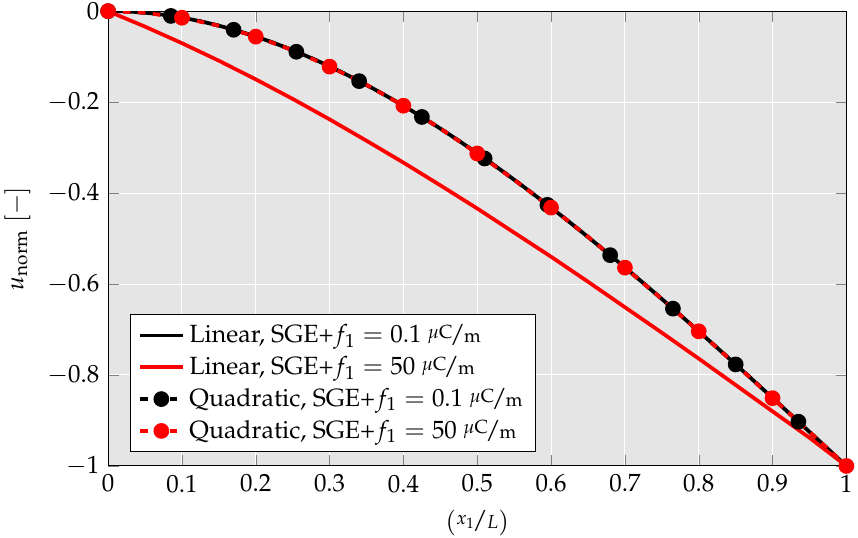
Figure 26. Comparison of cantilever beam bending for a small and high flexoelectric coefficient by using the linear and quadratic